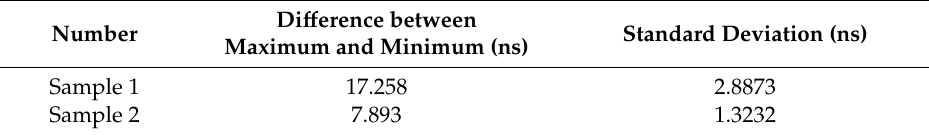
Table 2. Zero-drift data